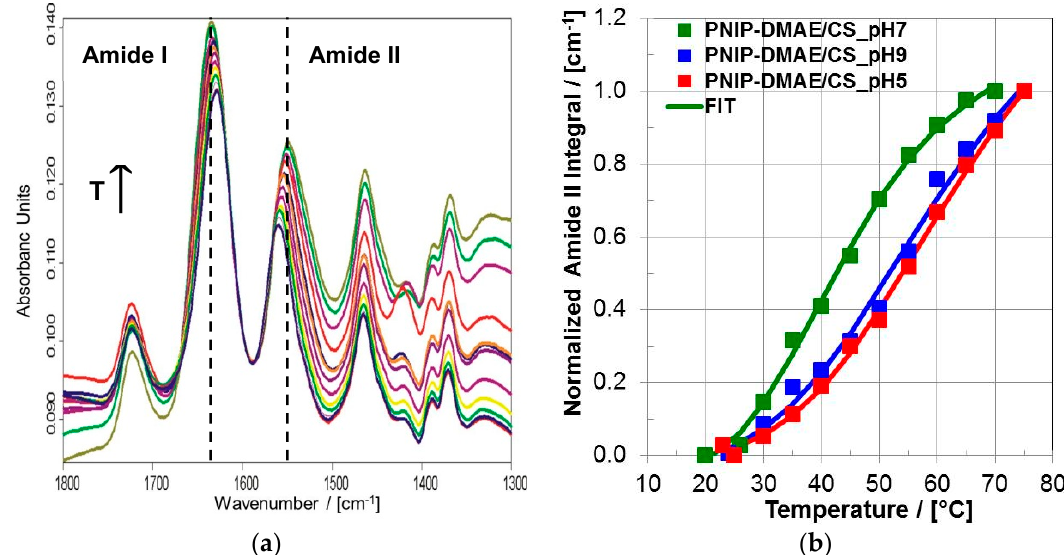
Figure 5. ( a ) Typical situ ATR-FTIR spectra on casted films of PNIPAM-DMAEMA/CS-1.2 in contact to HEPES buffer (pH = 9.0) for varying temperatures T (24 ◦ C (dark blue, lowest Amide II intensity), 30, 35, 40, 45, 50, 55, 60, 65, 70, 75 ◦ C (olive, highest Amide II intensity). Broken lines give the wavenumber positions of Amide I and Amide II band. ( b ) Typical plots of the diagnostic Amide II integrals in ATR-FTIR spectra of PNIPAM-DMAEMA/CS coatings in contact to aqueous media with pH = 9.0, 7.0 and 5.0 versus temperature T. Full Circles are related to experimental data points, full lines to fits based on Equation (1).